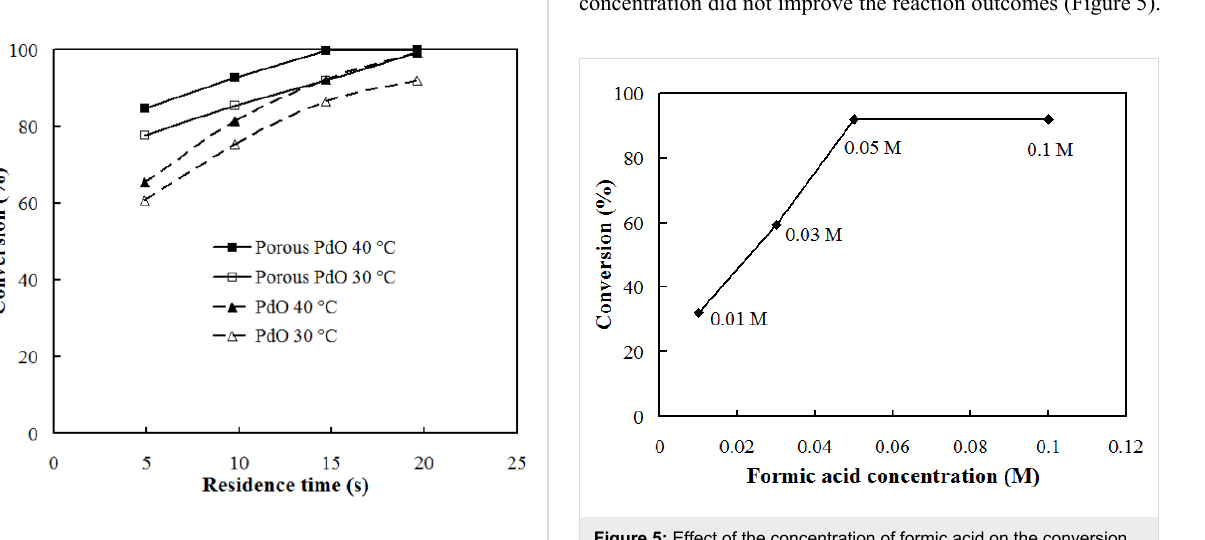
Figure 5: Effect of the concentration of formic acid on the conversion of 0.01 M p -nitrophenol. The formic acid concentration varied: 0.01 M, 0.03 M, 0.05 M and 0.1 M. Porous-PdO-coated reactor was used at 30 °C, with a residence time of 14.7